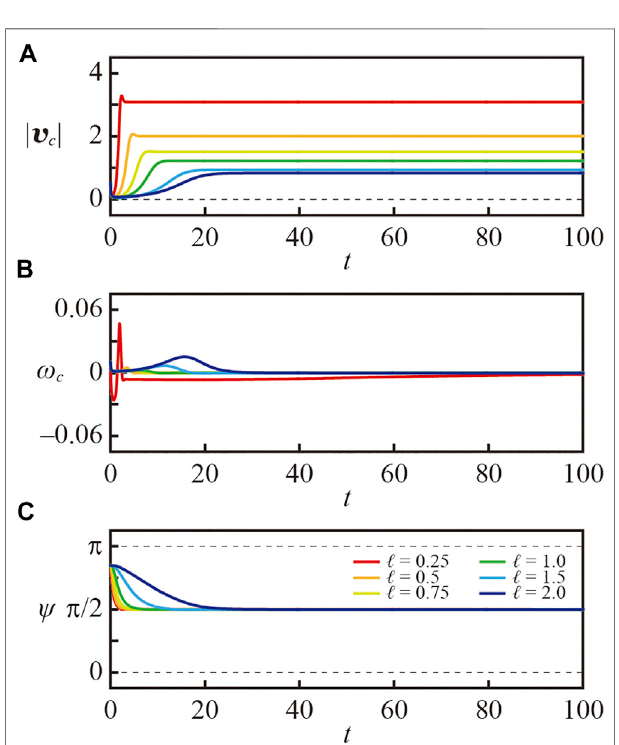
FIGURE 3 | Numerical results on the time series of (A) velocity, (B) angular velocity, and (C) angle difference between the velocity and characteristicangle θ c forthecamphor fl oatwith n =2. κ was fi xedto0.12.The results for various ℓ were represented in different colors. It should be noted that ψ has a periodicity of π